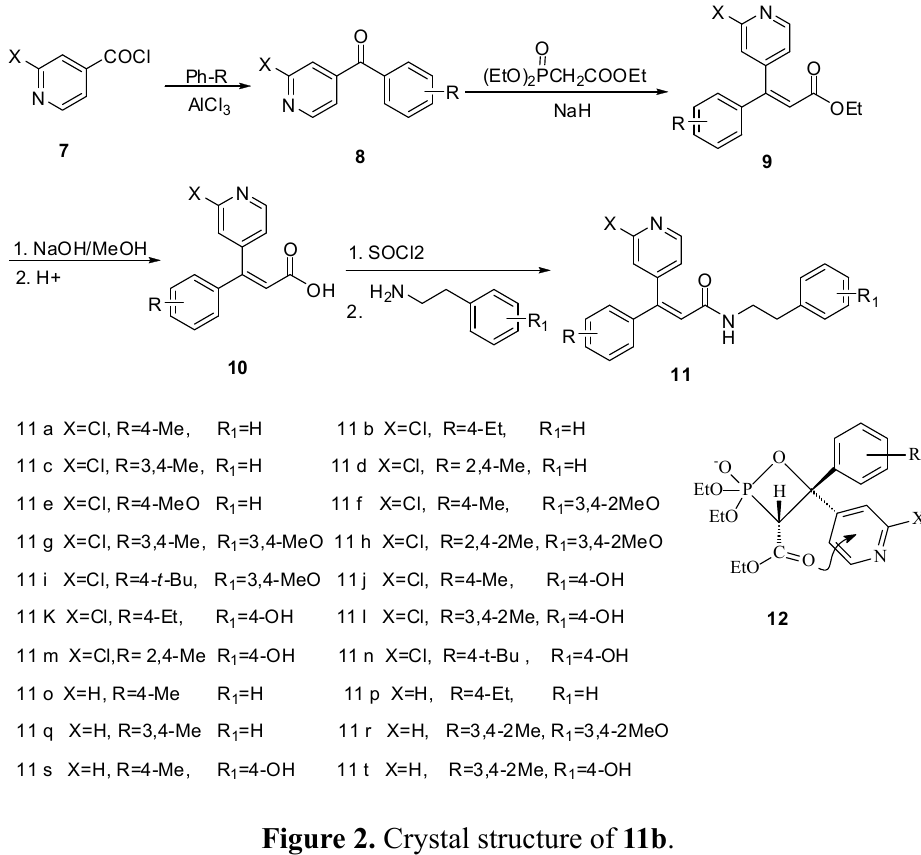
Figure 2. Crystal structure of 11b